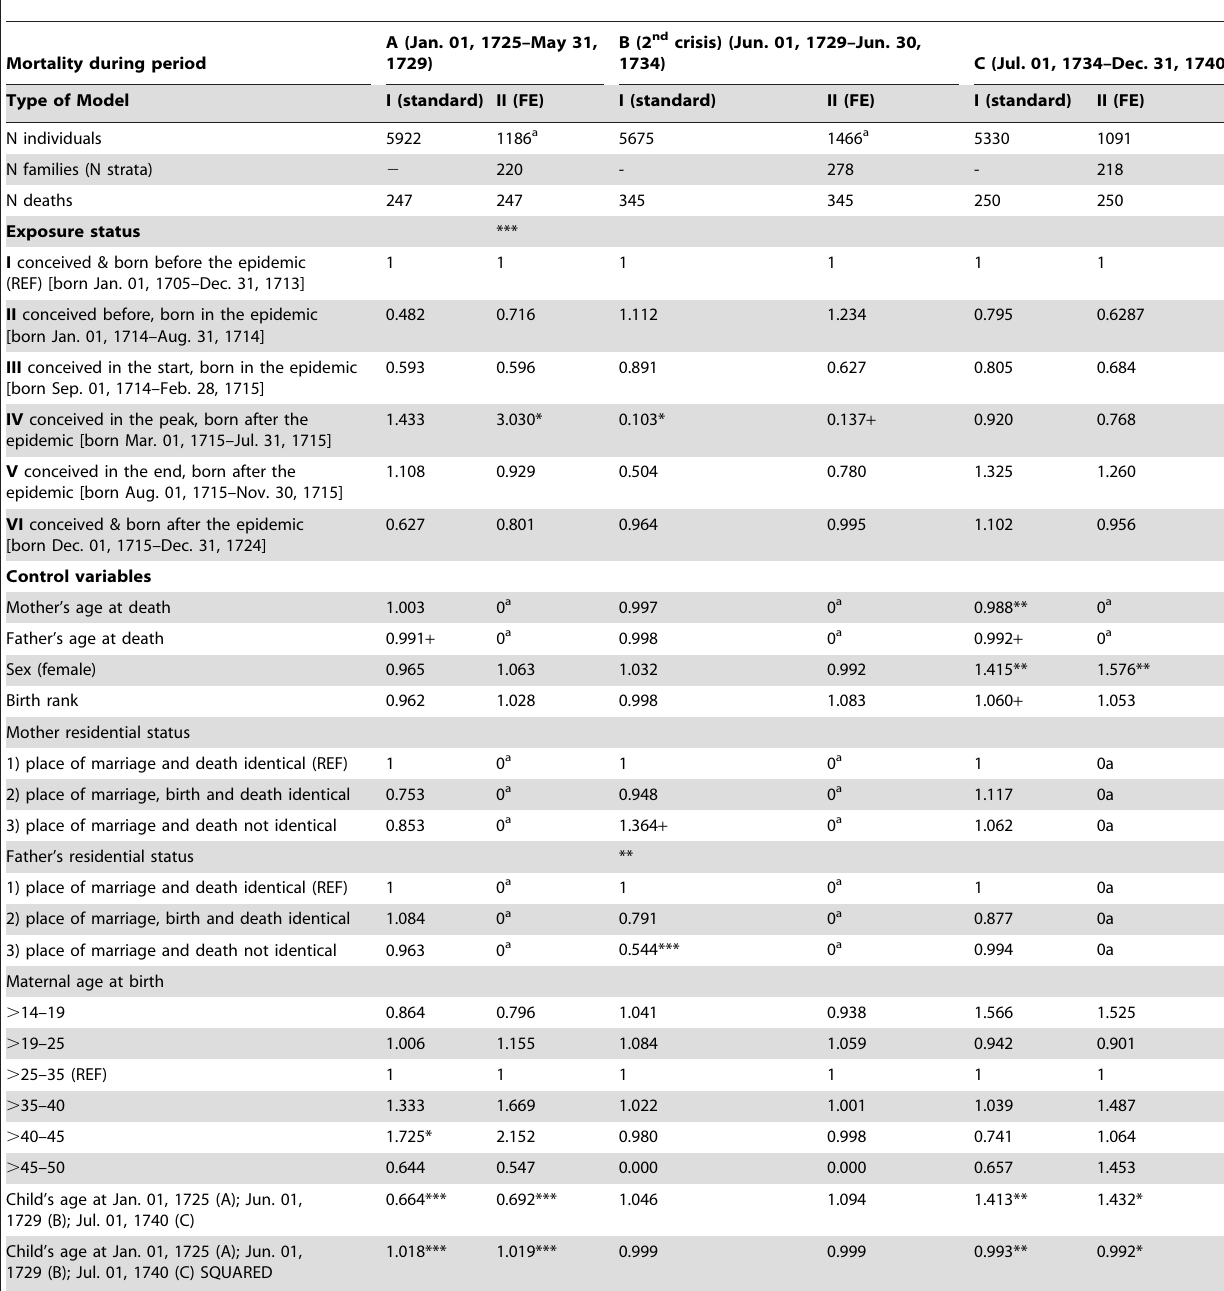
Table 2. Results of the Cox regression models, child mortality between Jan. 01, 1729 & May 31, 1729 (A), between Jun 01, 1729